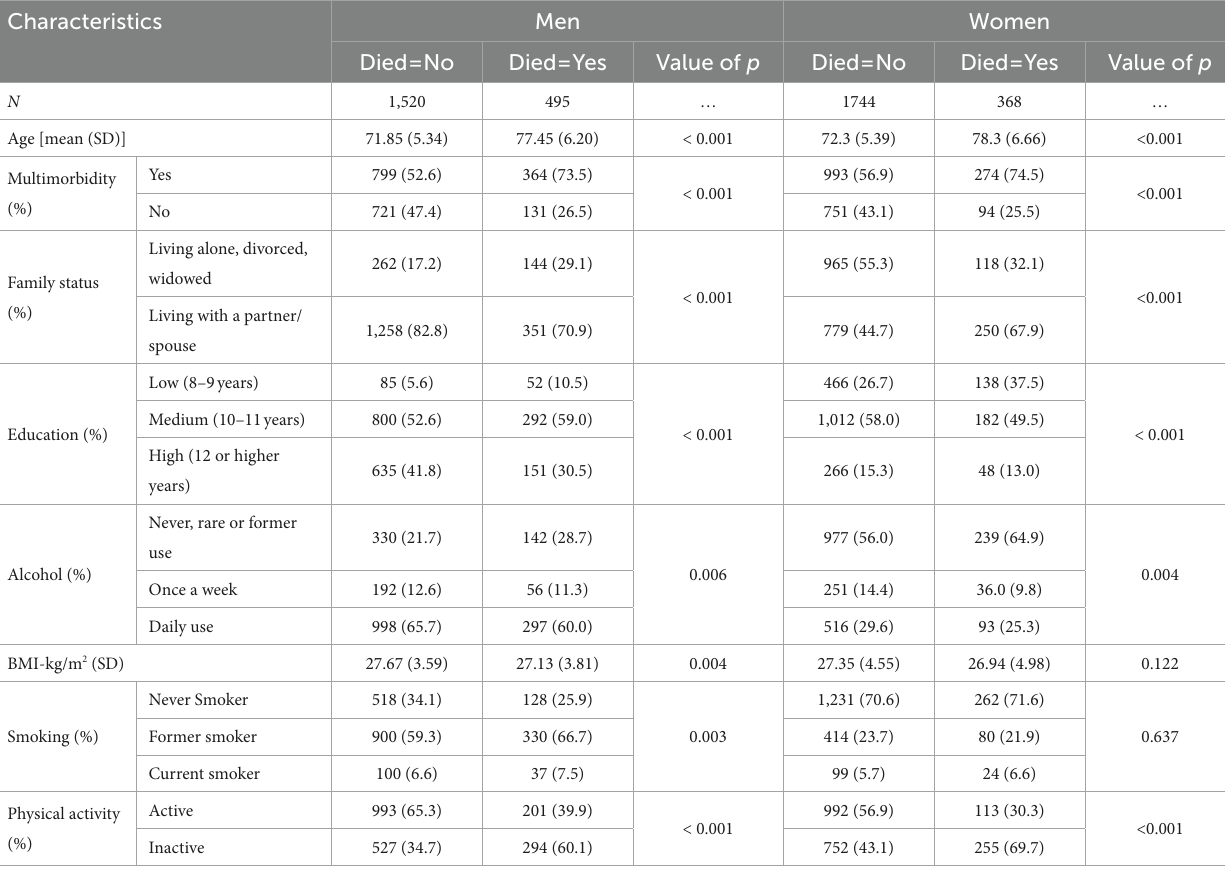
TABLE 1 Baseline characteristics of the study participants were stratified by sex and mortality status.